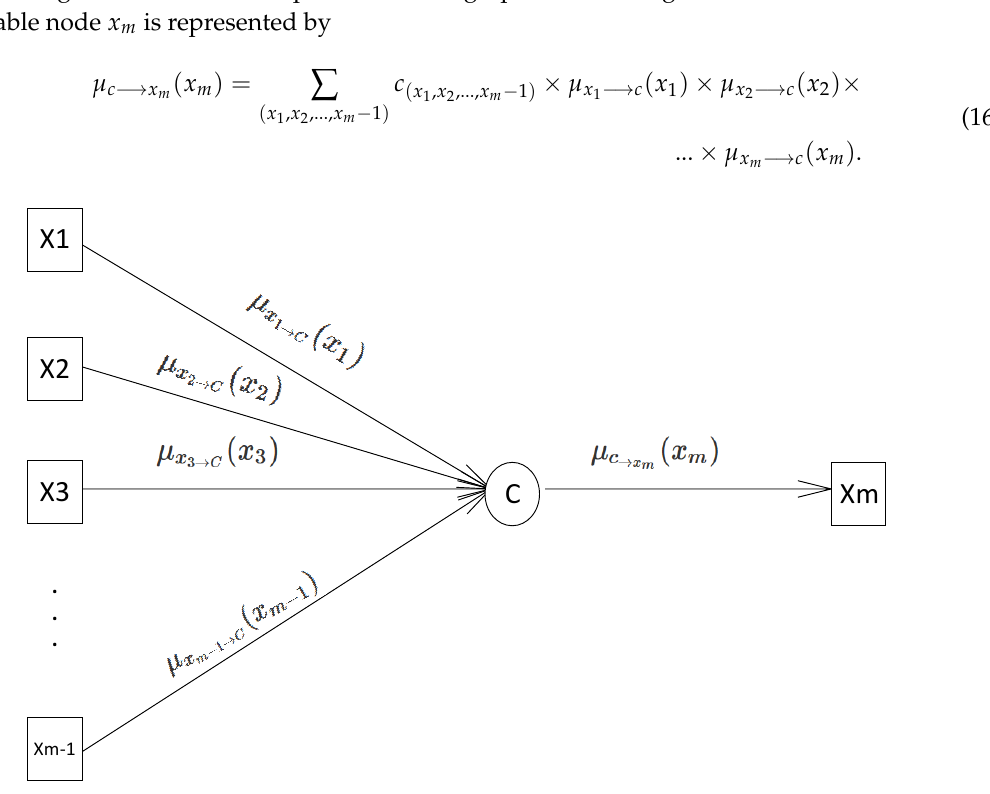
Figure 3. Message from connection node to variable